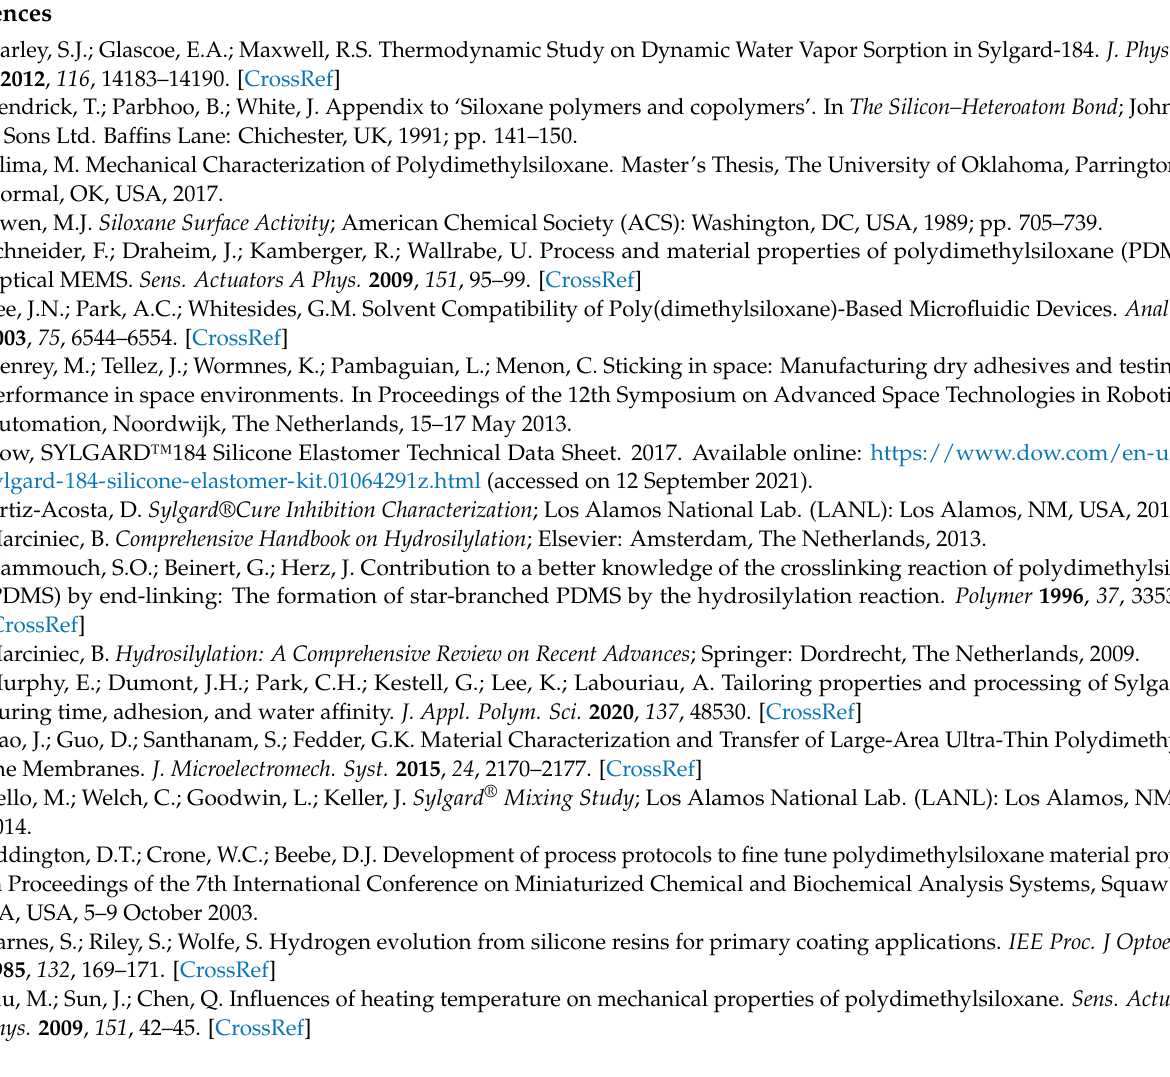
Figure A8. Validity of the TTS model for Shore A Hardness data, where ln ( a T t ) and 1 T(cid:3415) display a linear relationship for all modifications.